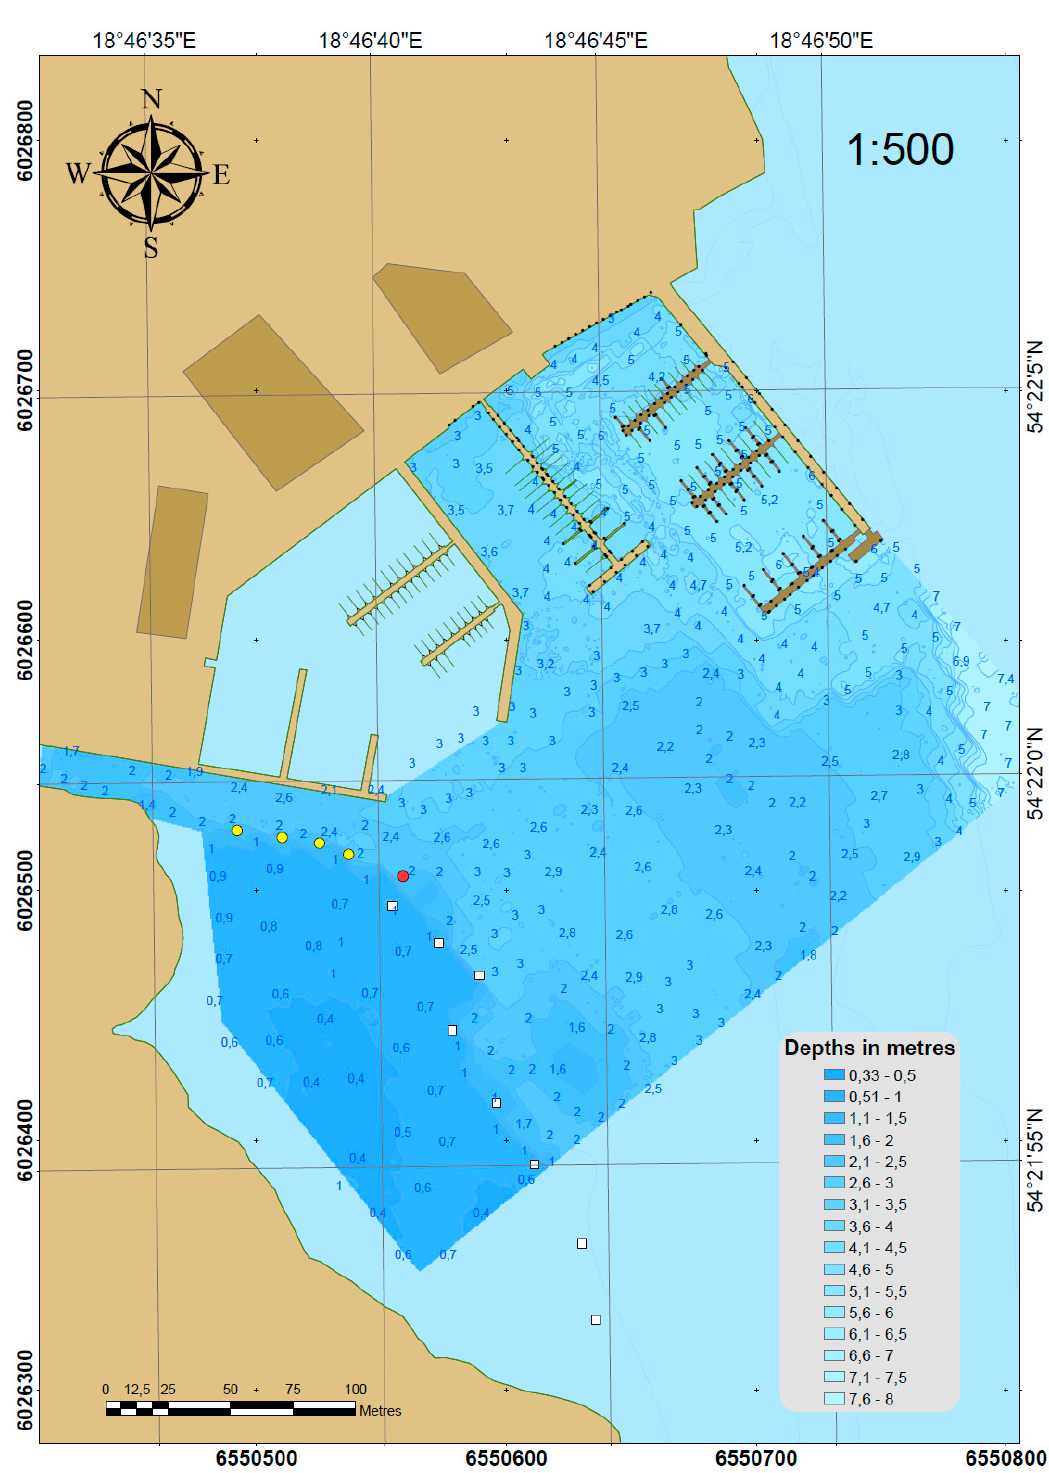
Figure 13. Bathymetric chart of the approach fairway to the National Sailing Centre at the Gda´nsk University of Physical Education and Sport (NSC-GUPES).